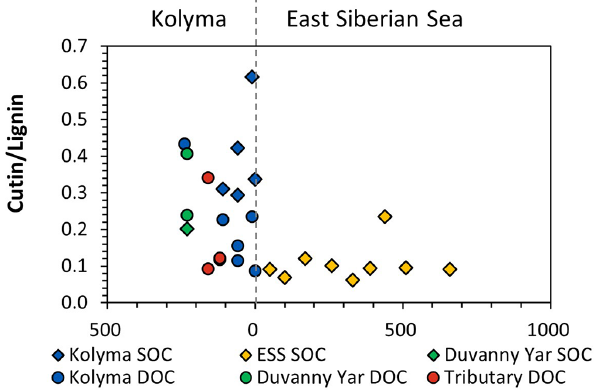
Figure A3. Cutin to Lignin ratios of Kolyma (blue), Duvanny Yar (green), tributaries (red), and East Siberian Sea (ESS; yellow) sediment organic carbon (SOC; diamonds) and dissolved organic carbon (DOC;